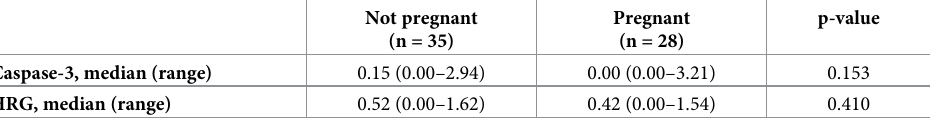
Table 4. Caspase-3 and HRG levels in secretomes from all transferred embryos resulting and not resulting in a pregnancy.